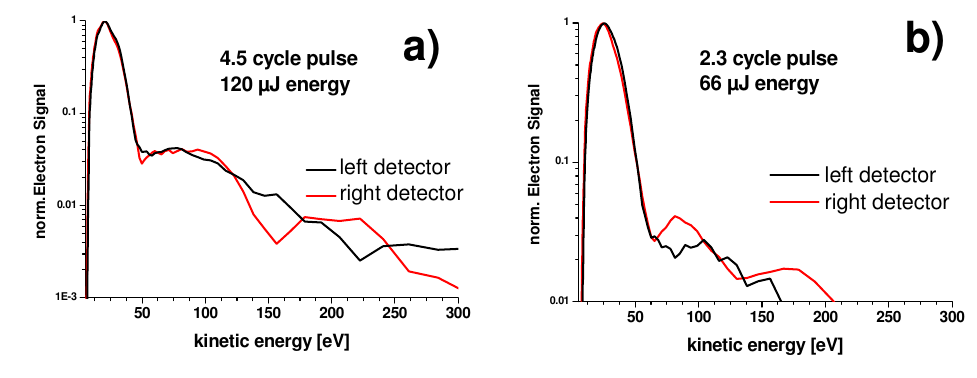
Fig. . Experimental setup for interferometrically CEP controlled high energy IR pulses based on passive CEP stabilization via difference frequency generation (DFG). The phase shift ( ∆φ ) of the 800 nm beam in arm 1 is preserved during self-phase modulation in the Sapphire window. This phase shift is transferred to the Idler in the DFG process and maintained in the subsequent amplification stages. In addition to the cycle dependent yield of rescattered electrons, we observed a very pronounced CEP dependence for the direct electrons which is characterized by the asymmetry parameter A = (left-right)/(left + right). An asymmetry parameter of 60% was reached for certain parts in the direct electron